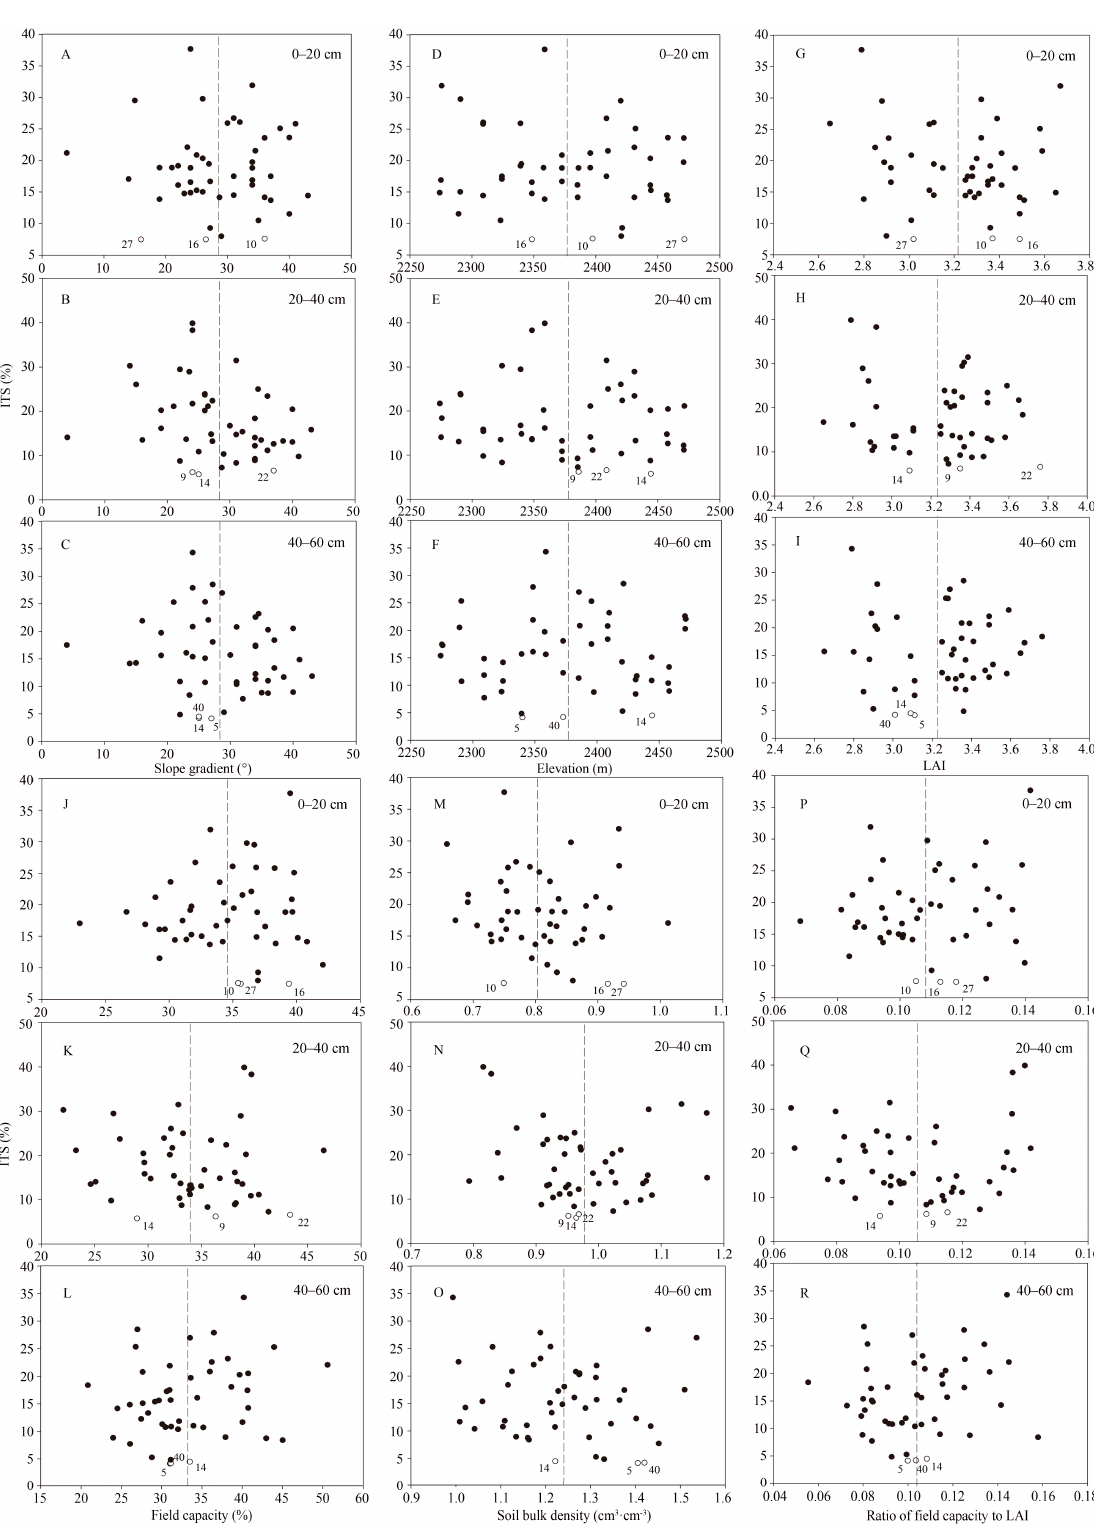
Figure 10. Relationships between ITS and slope gradient ( A – C ), elevation ( D – F ), LAI ( G – I ), soil field capacity ( J – L ), soil bulk density ( M – O ), and the ratio of field capacity to leaf area index (LAI) ( P – R ) in different soil layers (0–20, 20–40, and 40–60 cm). The dash lines denote the mean values of affecting factors.